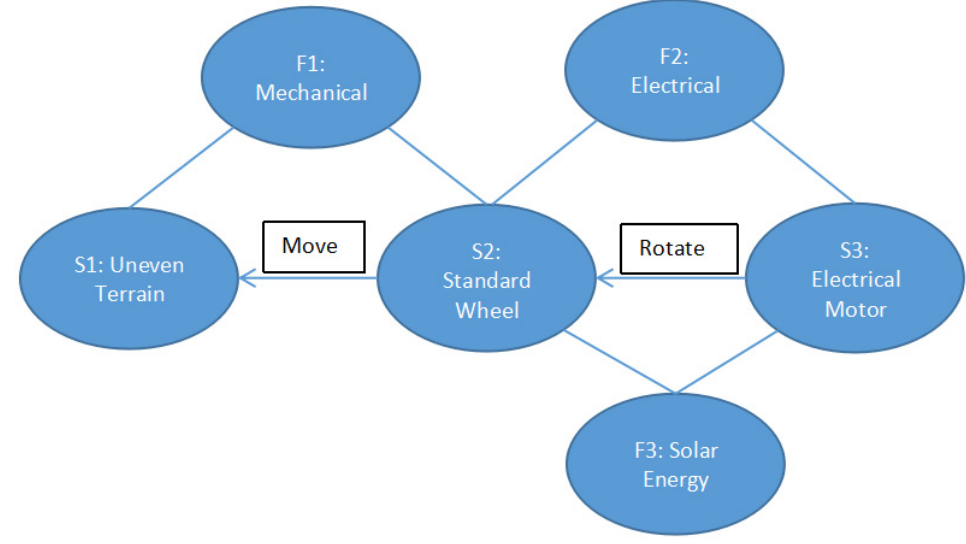
Figure 4. Improved Su-field model for constraint 1.